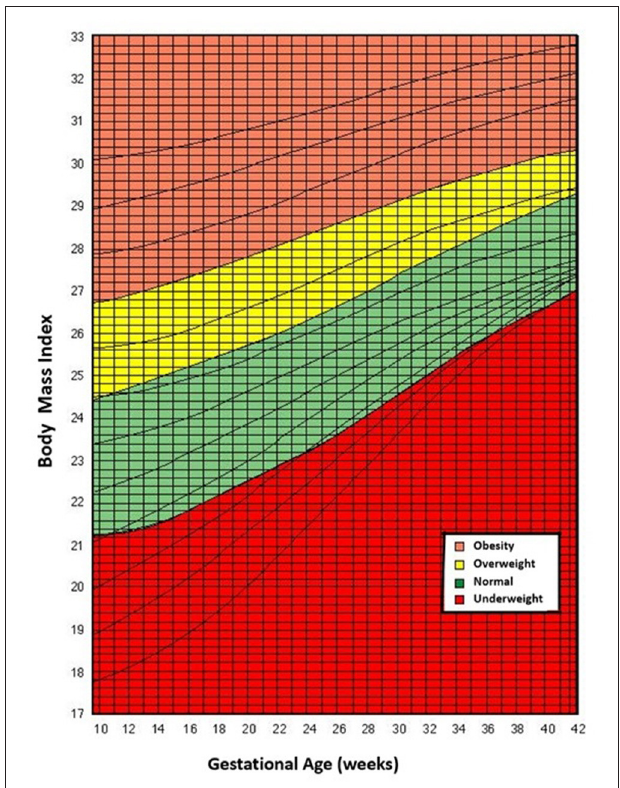
FIGURE 1 | Rosso-Mardones chart.